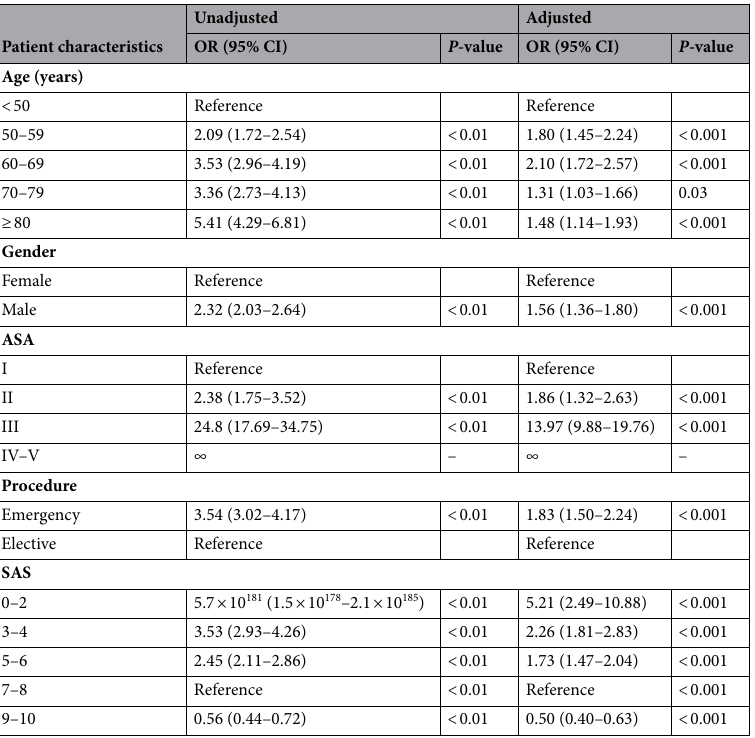
Table 3. Variables associated with immediate ICU admission as determined by univariate and multivariate analyses, with unadjusted and adjusted odds ratios (ORs) and 95% confidence intervals (CIs). ICU intensive care unit, ASA American Society of Anesthesiologists, SAS surgical Apgar score. ∞: infinity. † –: unable to